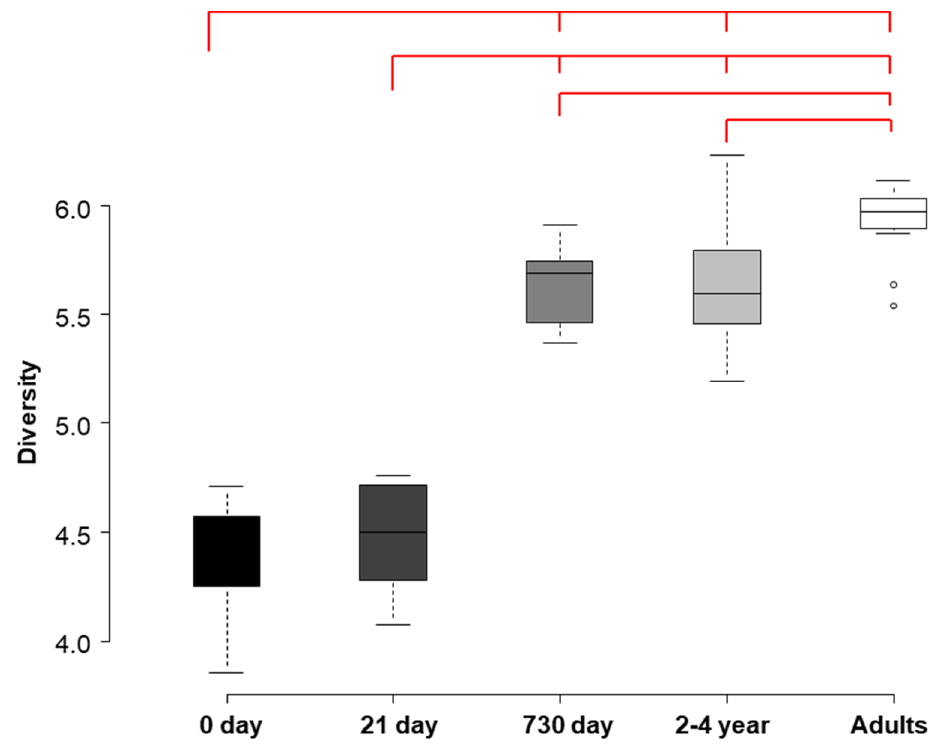
Figure 4. Development of the intestinal microbiota diversity. Shannon–Weaver diversity indices are shown for the intestinal microbiota in the meconium, third week and 2 ‐ year fecal samples of preterm infants. Boxes at the right and middle represent the Shannon–Weaver diversity index obtained in meconium, 21 ‐ day and 2 ‐ year feces. Boxes on the right represent Shannon–Weaver diversity indexes previously obtained with the Human Intestinal Tract Chip (HITChip) in feces, from 2 and 4 ‐ year ‐ old healthy infants and from healthy adults. The red bars on the top represent pairs of indices that were found to be statistically different ( p < 0.001).